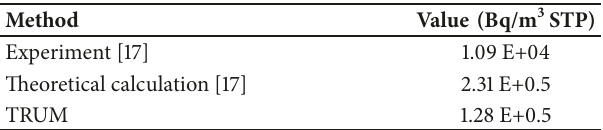
Table 8: The comparison of experiment result, theoretical calcula- tion, and HTR-STAC result of tritium in the primary loop of